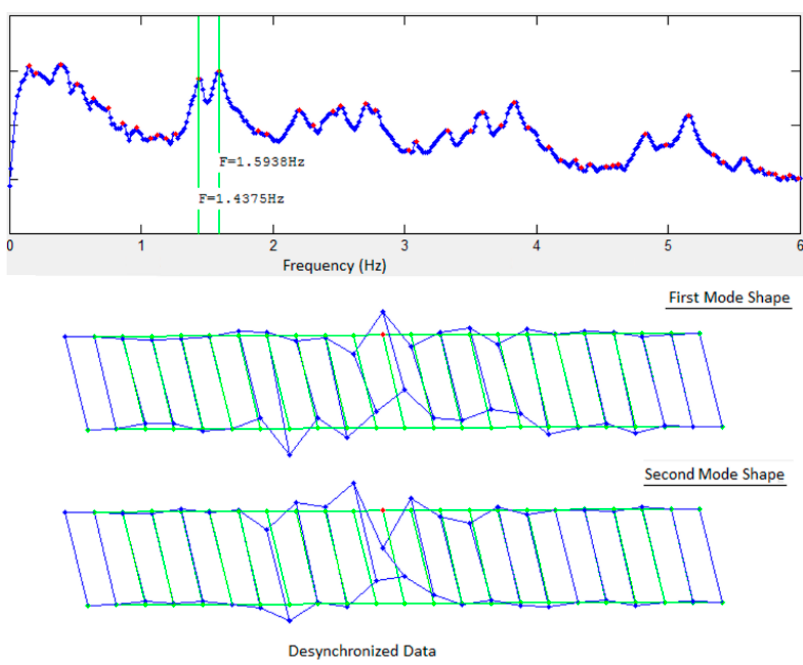
Figure 4. Singular value plots and first two mode shapes for de-synchronized data.